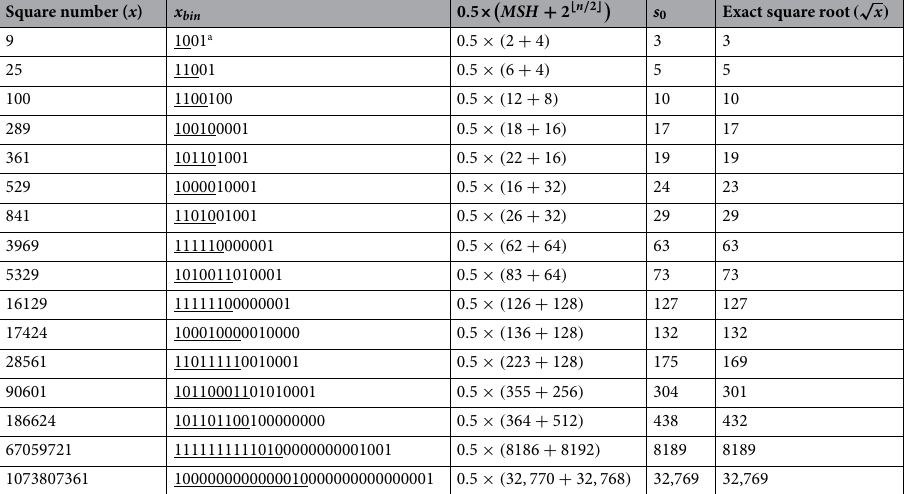
Table 1. Initial estimations of s 0 for selected integer square numbers. representation indicates the most significant half (MSH) of x bin